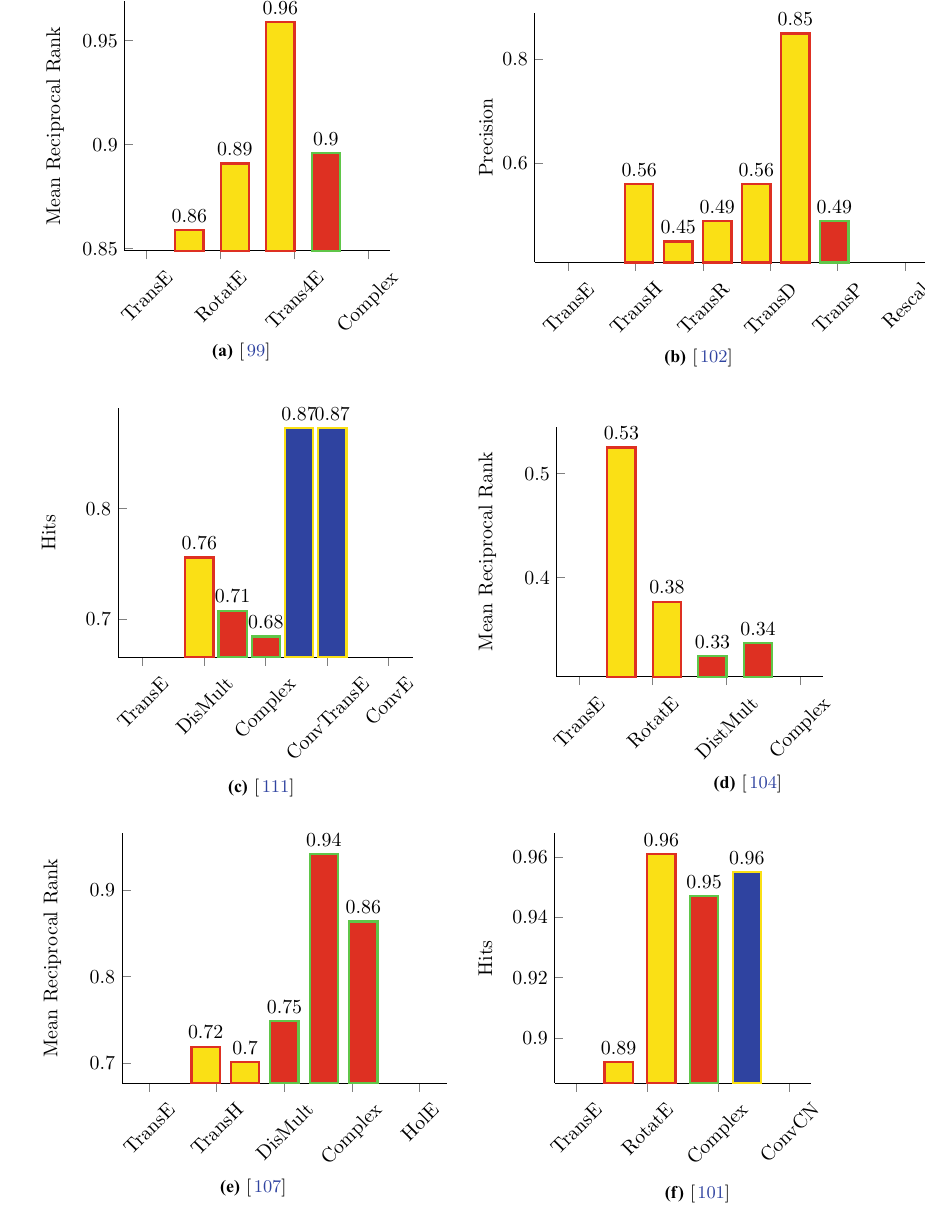
Fig. 5 Comparison of papers based upon precision, hits and mean reciprocal